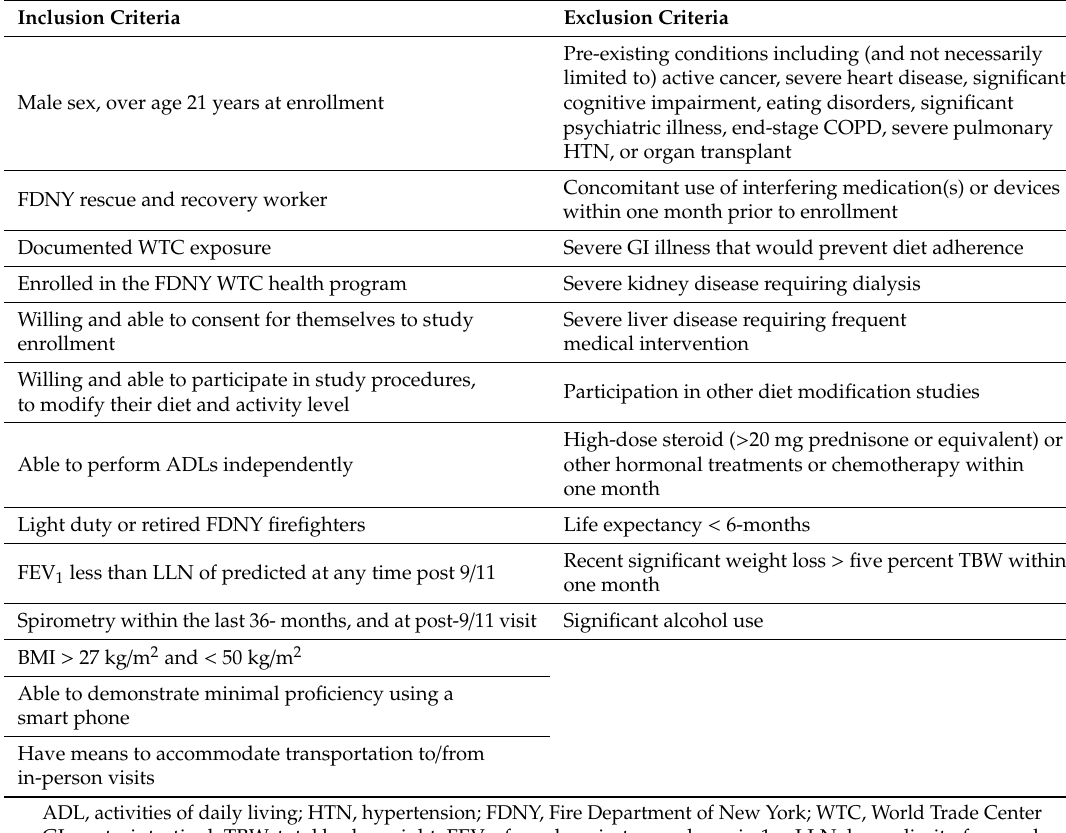
Table 1. Inclusion and exclusion criteria for the randomized controlled clinical trial (RCT) FIREHOUSE